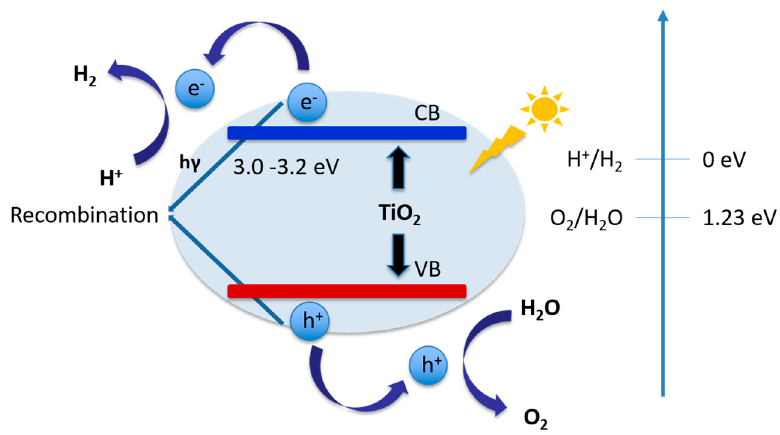
Figure 4. Schematic band gap diagram of TiO 2 . Figure adapted from references [4,149] of Moniz et al. and Miao et al. works respectively.